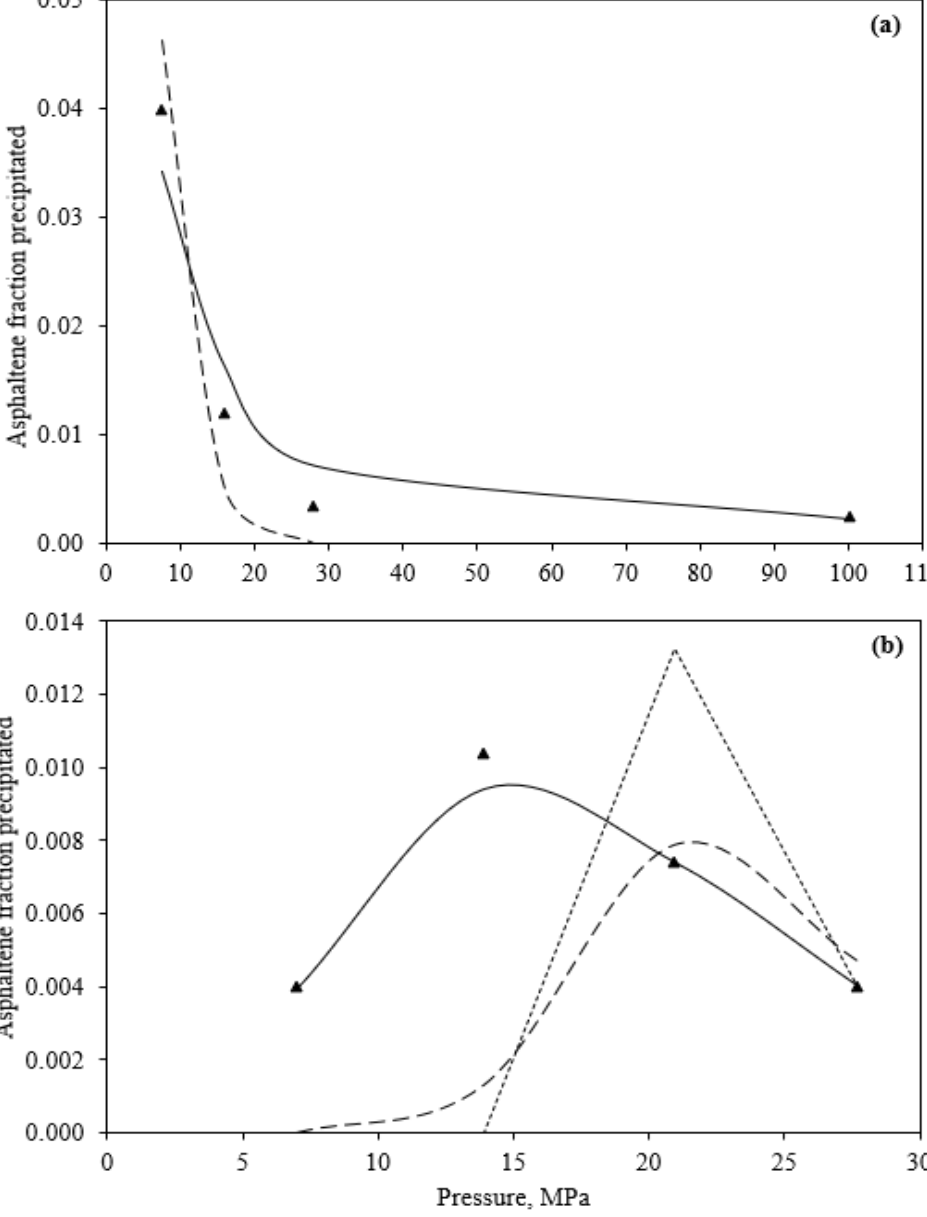
◦ C, ( — ) calculated by Pan and